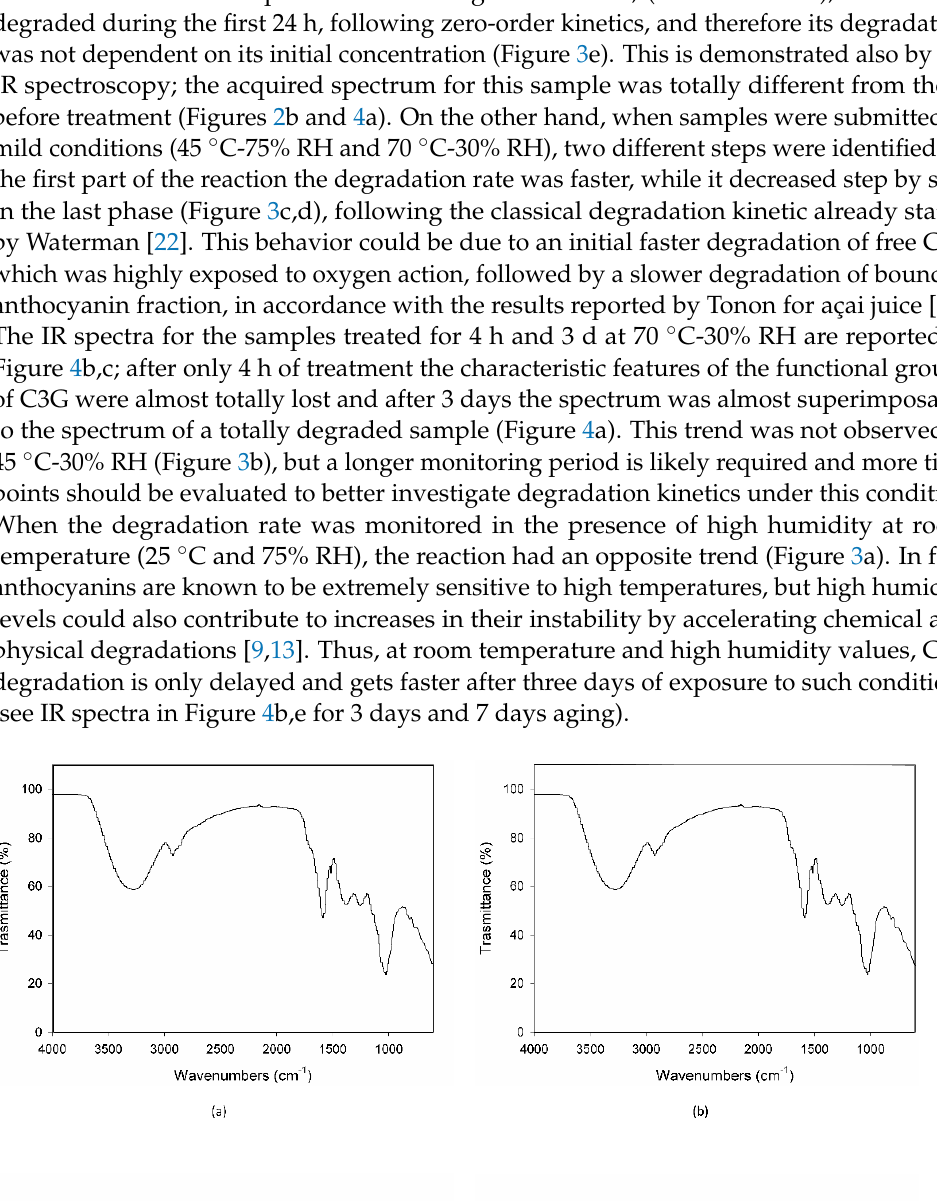
Figure 4. IR spectra of the MCE-20% AG ( w / w ) after 24 h of degradation at 70 °C-75% RH ( a ), after 4 h ( b ) and 3 days of degradation at 70 °C-30% RH ( c ), and after 3 ( d ) and 7 days of degradation at 25 °C-75% RH ( e ). In Figure 5, the DSC profiles of the same samples discussed for the IR results are reported. As evident in all of the plots, no signals attributable to C3G are present, with the exception of a small shoulder in Figure 5b, confirming its degradation due to ageing.